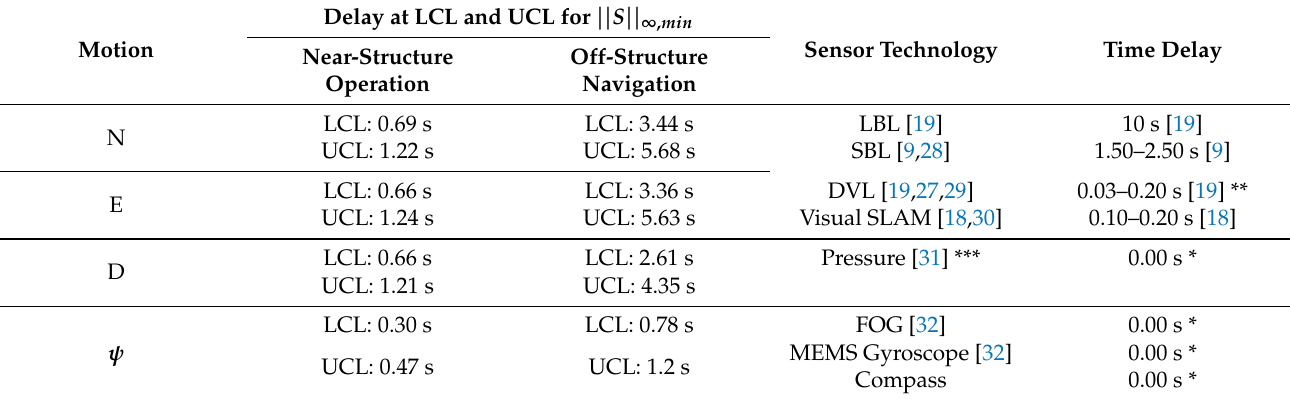
Table 12. Typical motion sensor technologies and associated time